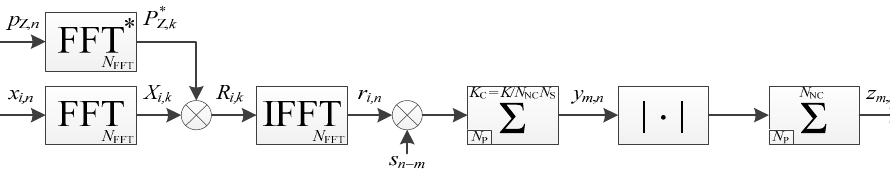
Figure 9. Implementation of a pilot channel acquisition, with non-coherent accumulation, in a serial way (timing diagram available in Figure 7).